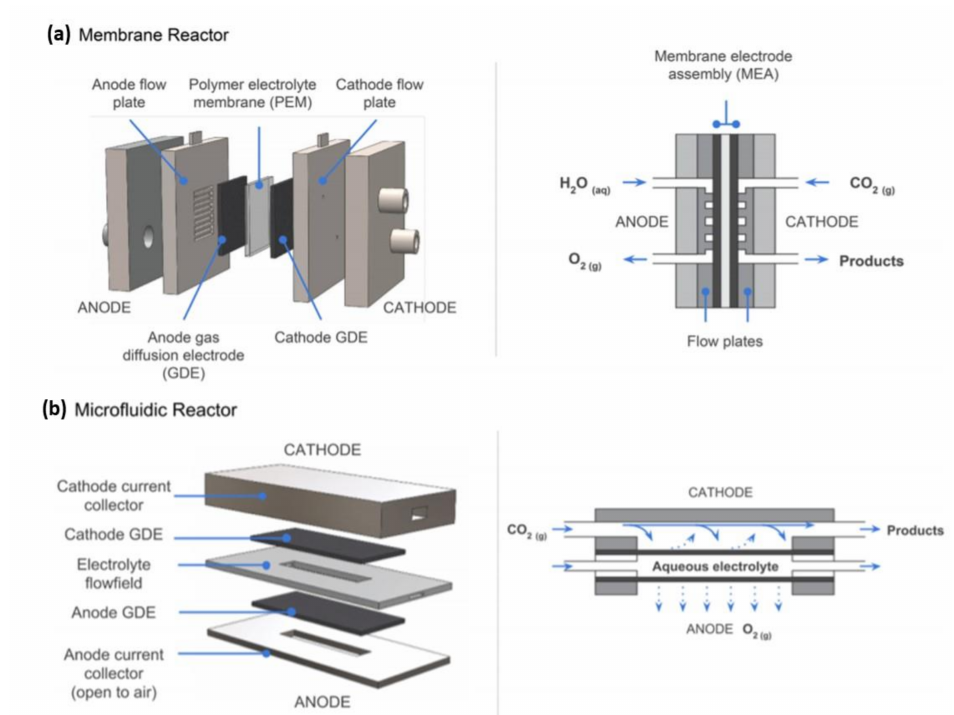
Figure 4. Schematic representation of continuous-flow reactors for testing CO 2 electro-reduction. In detail: ( a ) Membrane-based reactor; ( b ) Microfluidic reactor. The main feature of membrane reactors is an ion-exchange membrane separating the anodic and cathodic compartments, hence enabling an easier separation of the products and avoiding their re-oxidation. On the other hand, in microfluidic reactors, separation of the electrodes is guaranteed by a flowing electrolyte within a millimetric channel, which enables a better electrode wettability. Reprinted with permission from Ref. [48]. Copyright 2022 American Chemical